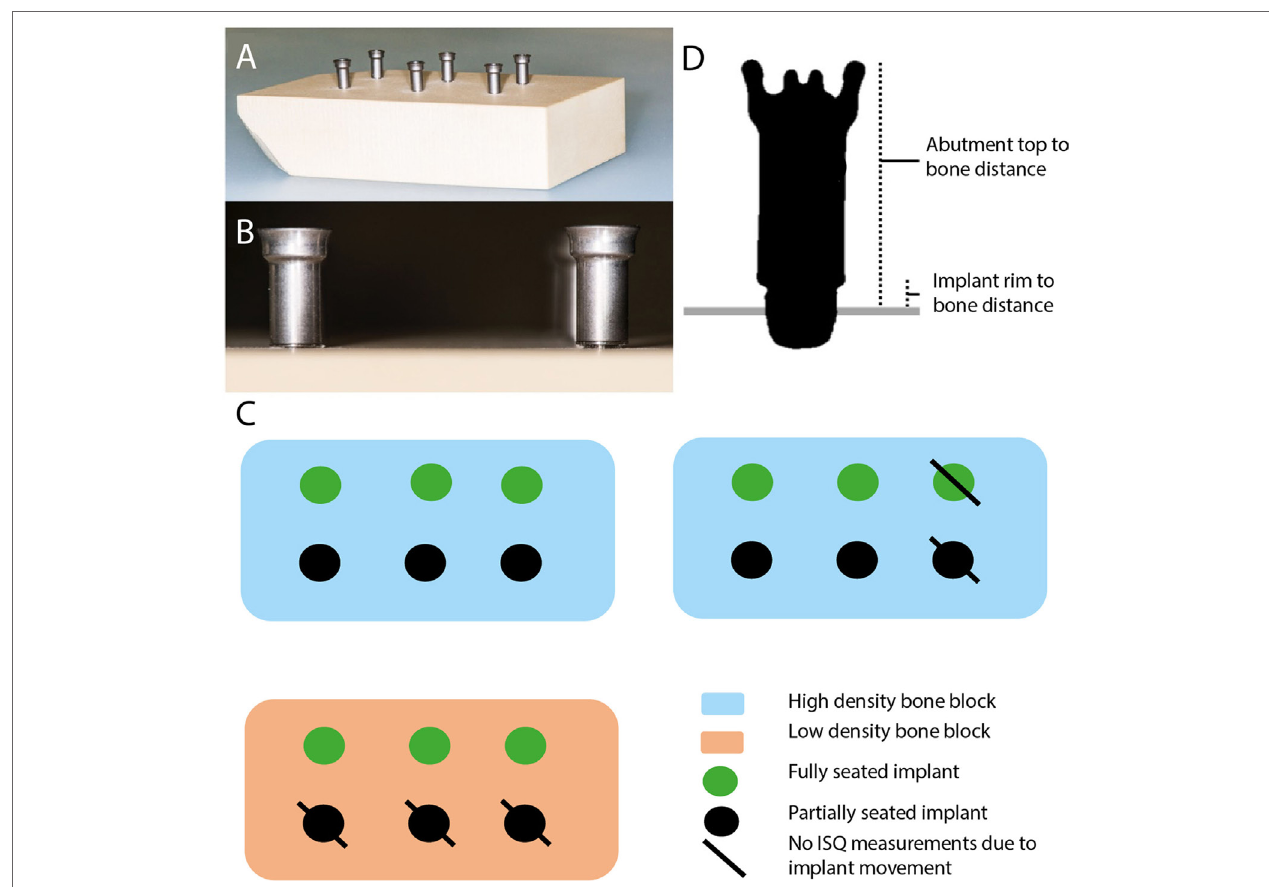
FIgURe 1 | Overview of the system and the measurement points. (A) Overview of artificial bone block with installed implant. (B) Overview of fully seated bone conduction hearing implant (BCHI) (left) and partially seated BCHI (right). (c) Overview of artificial bone blocks. BCHI insertion measurements were performed on all bone blocks. \ indicates implants not used for implant stability quotient (ISQ) measurements due to gross implant mobility. (D) Coronal cross section plane of the BCHI. Measurement points are placed at the abutment top, bottom of the implant rim, and (artificial) bone at four equally spaced quadrants. In this exemplary case, the implant is partially